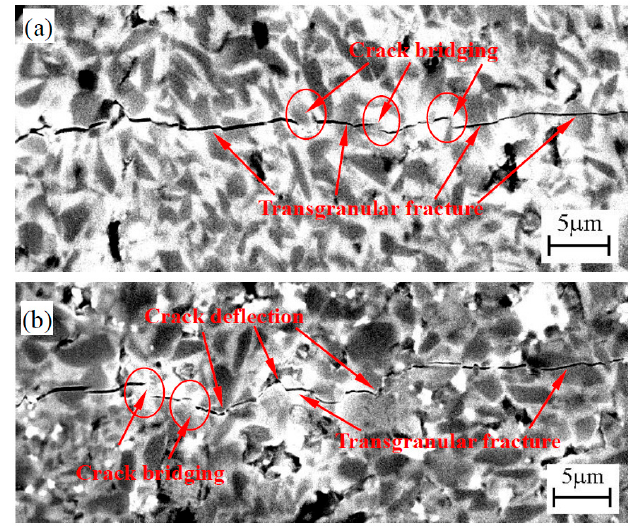
Figure 7. Crack propagation path of the TiB 2 -HfB 2 ( a ) and TiB 2 -HfN ( b ) ceramic tool materials.